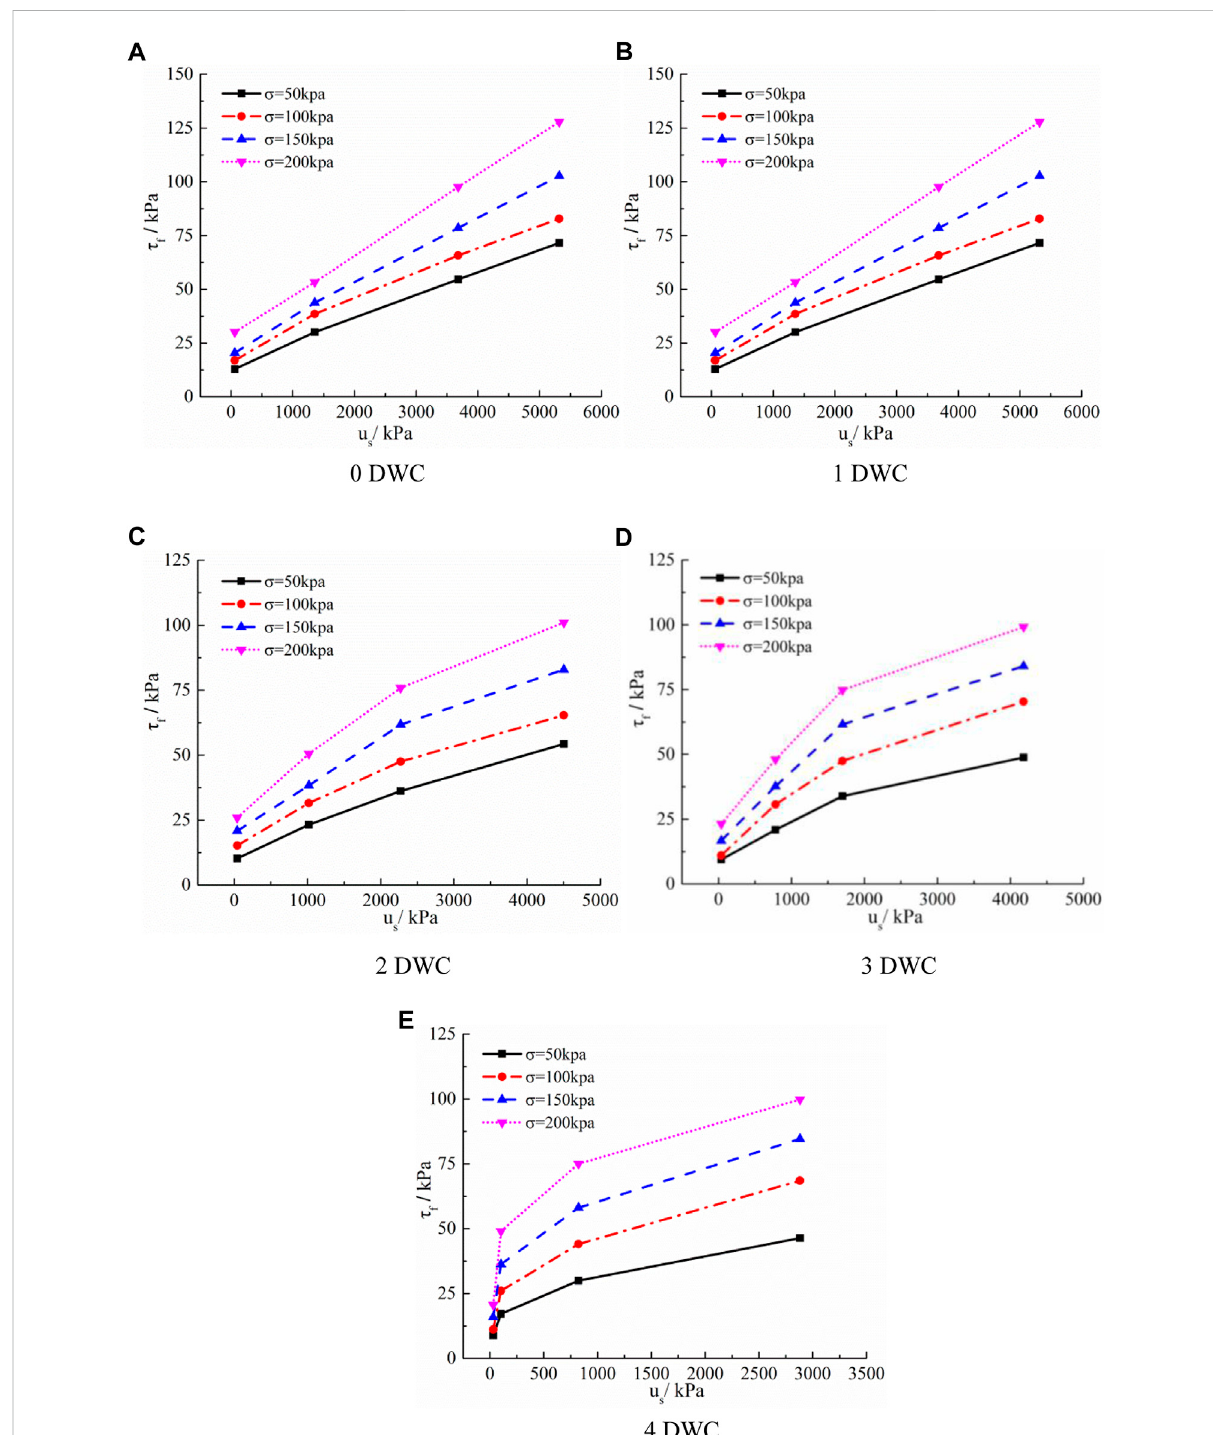
FIGURE 4 Relationship between the shear strength and the matric suction of the samples under the different DWC (A) . 0 DWC (B) . One DWC (C) . Two DWC (D) . Three DWC (E) . Four